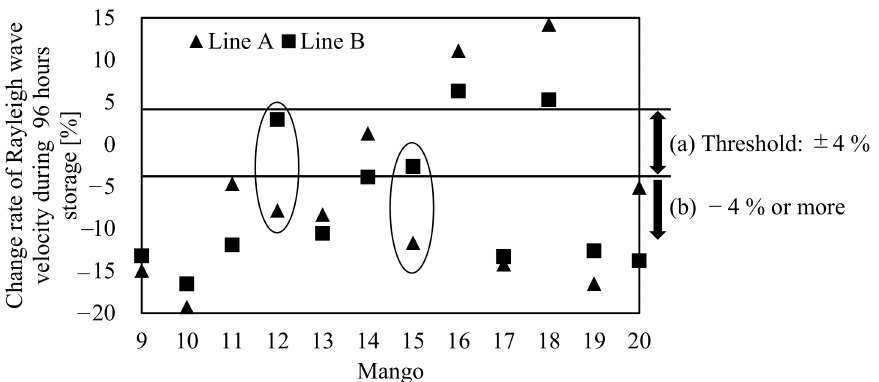
Figure 12. Change rate of Rayleigh wave velocity measured around Line A and Line B of mangoes 9–20 during 96-h storage. ( a ) Change rates of Rayleigh wave are within threshold. ( b ) Change rate of Rayleigh wave exceeds